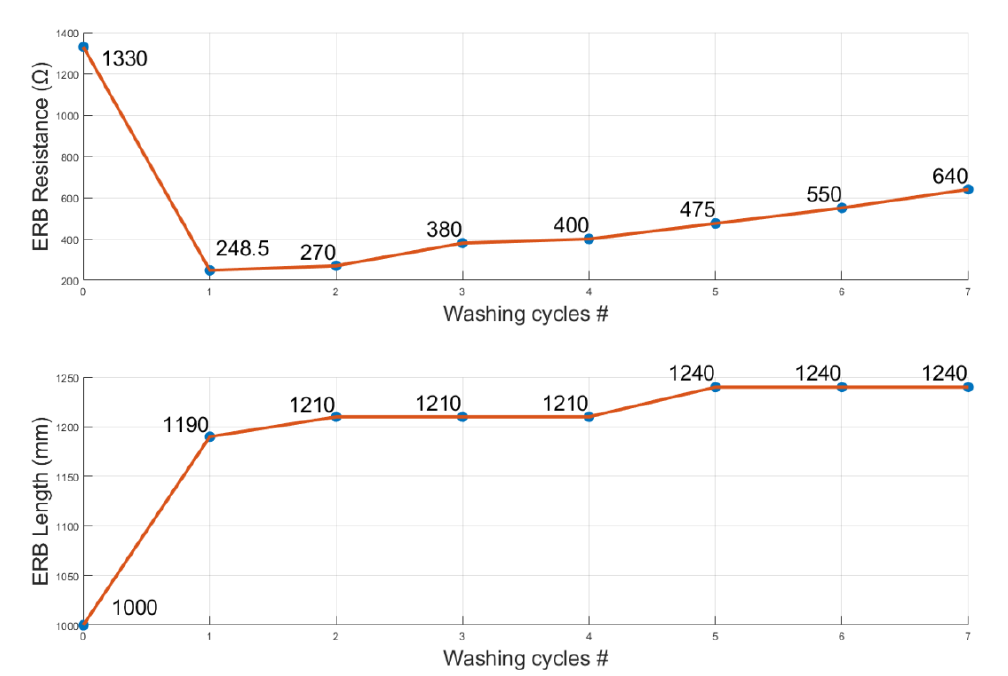
Figure 29. The ERB resistance and length after seven washing